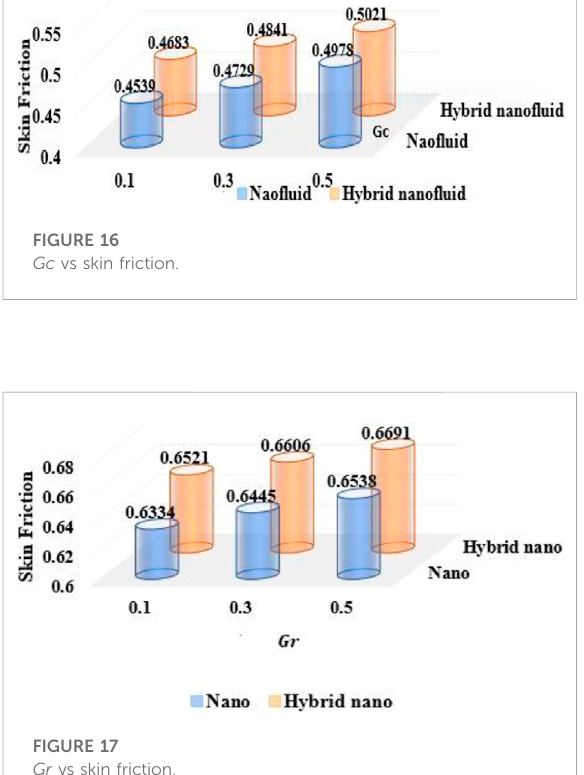
FIGURE 17 Gr vs skin friction.